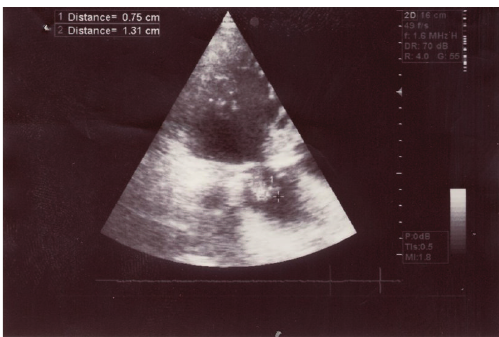
Figure 1: Vegetation on the aortic valve noncoronary leaflet (cus-